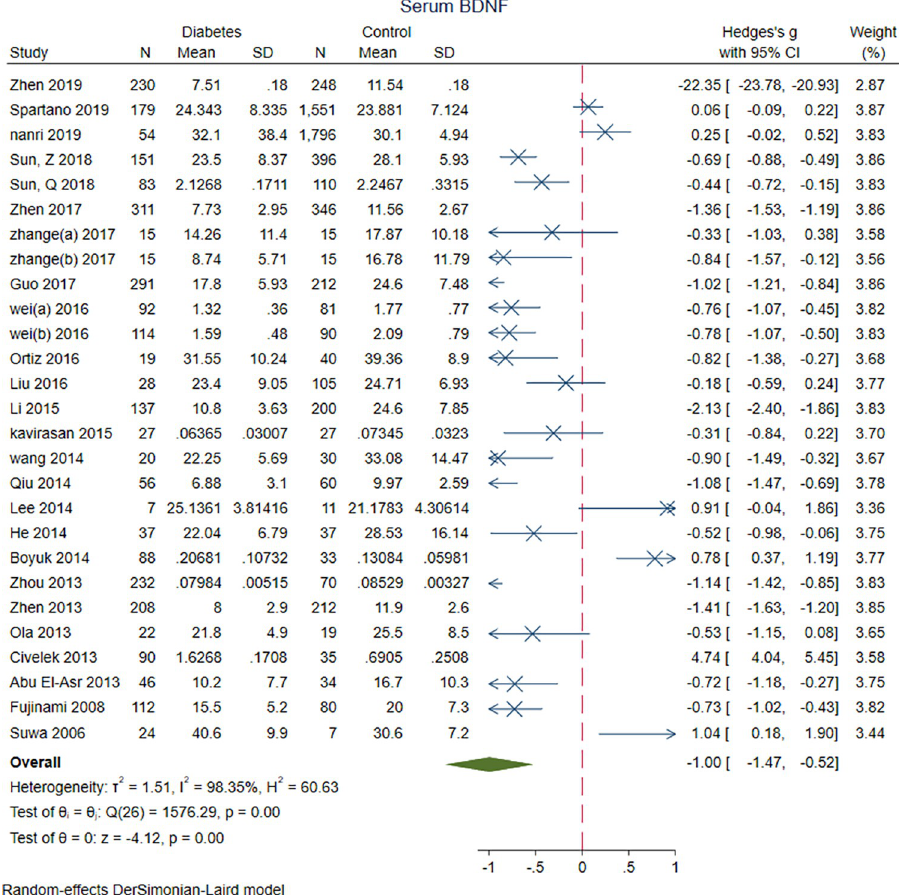
Meta-analysis of three studies demonstrated significantly lower levels of serum BDNF in patients with DM and DR (n = 123) compared to the controls (n = 80) (SMD = -1.03 [-1.81, -0.25], P = 0.01) (Fig 6).